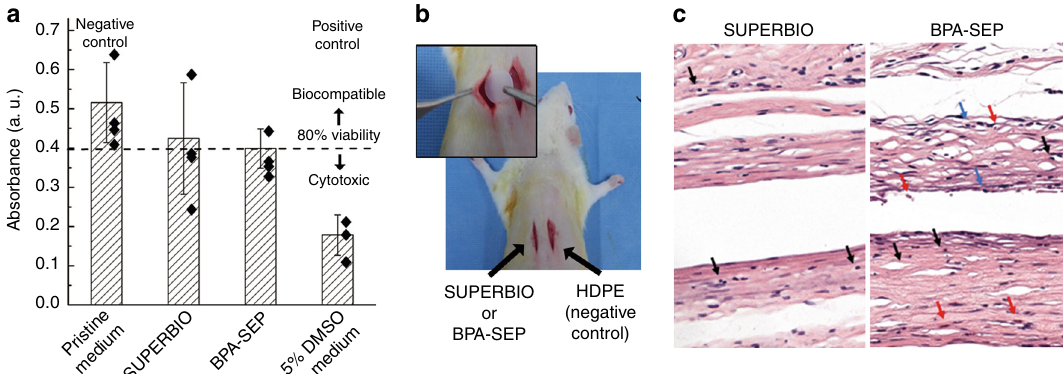
Fig. 5 In vitro and in vivo biocompatibility tests. a In vitro cytotoxicity tests using pristine media (negative control) and those containing 5% DMSO (positive control) or polymer fi lm extracts, following ISO 10993-5. Each value represents the mean and standard deviation of quintuplicate samples. b In vivo experiment procedure: rat subcutaneous connective tissues ( n = 5) with HDPE (negative control), SUPERBIO, and BPA-SEP fi lms. c Representative histopathologic tissue images after 12 weeks of healing. Arrows for in fl ammatory cells: red (polymorphonuclear cell), black (lymphocyte), and blue fi xing and dyeing processes. The histopathological tissue images